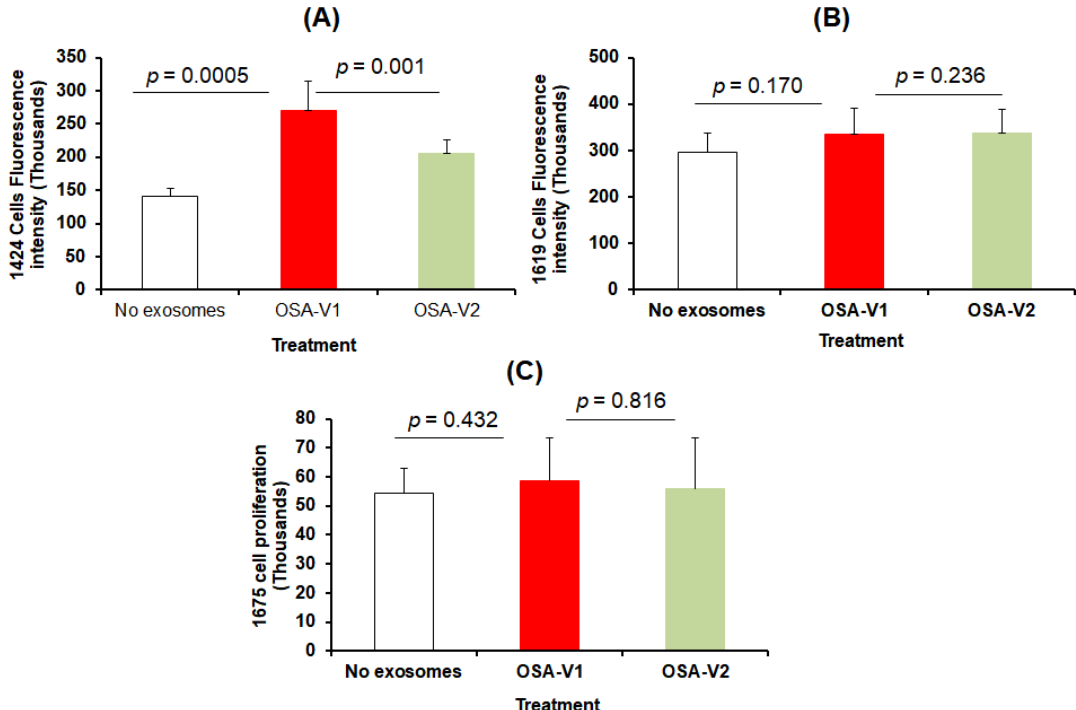
Figure 2. Effects of plasma exosomes-derived from OSA patients before CPAP treatment (OSA-V1) and after adherent CPAP treatment for 1 year (OSA-V2) on melanoma cells proliferation. Exosomes-derived from OSA patients were incubated in 96-wells plates for 24 h. The cells were treated with CyQUANT GR dye/cell lysis buffer, and the fluorescence was measured using a microplate reader (the excitation maximum was 485 nm, and the emission maximum was 530 nm). ( A ) represents the average of fluorescence intensity of cell proliferation for CRL-1424 cells, ( B ) CRL-1619 cells, and ( C ) CRL-1675 cells with statistical significance set at p < 0.05 ( n = 20/condition).